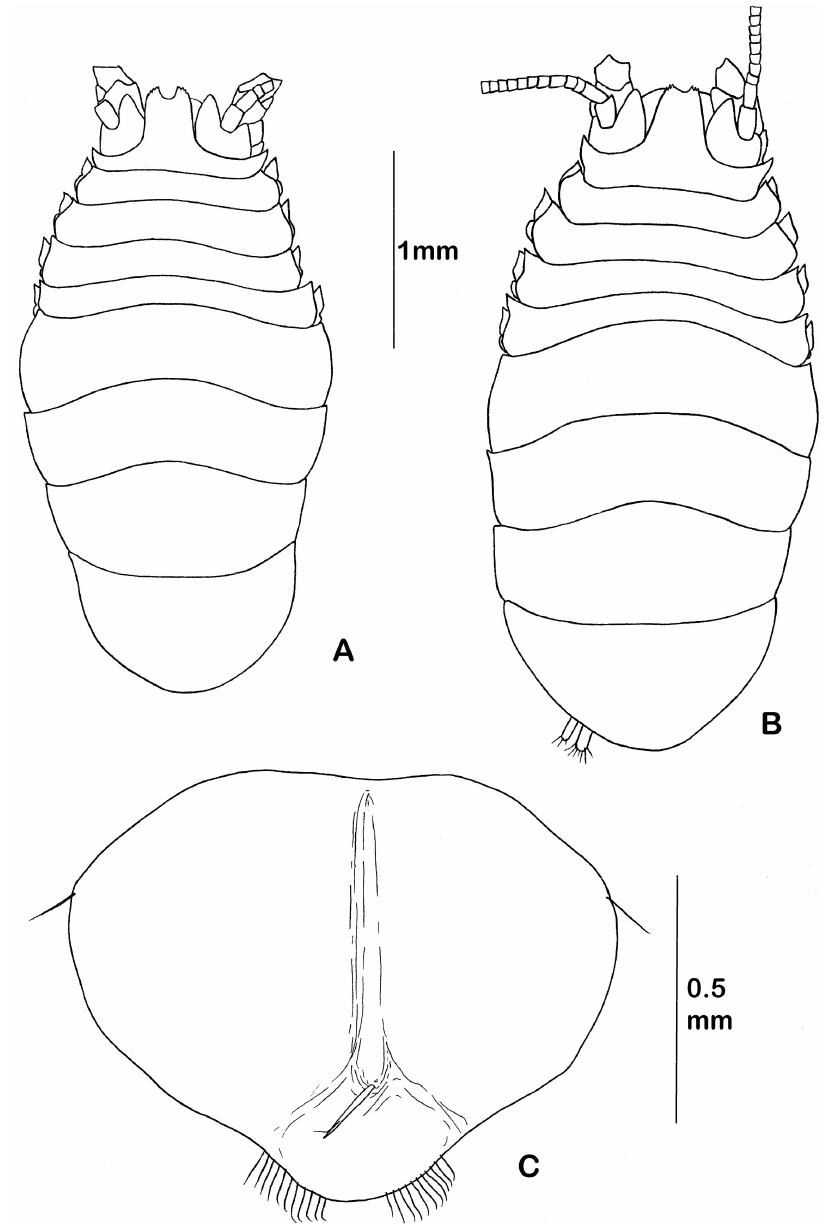
Figure 9. Eurycope producta GO Sars, 1868. Female (ZMH K-45583): ( A ) dorsal view; female (ZMH K-45584): ( B ) dorsal view; female (ZMH K-45583): ( C ) pleopod II.